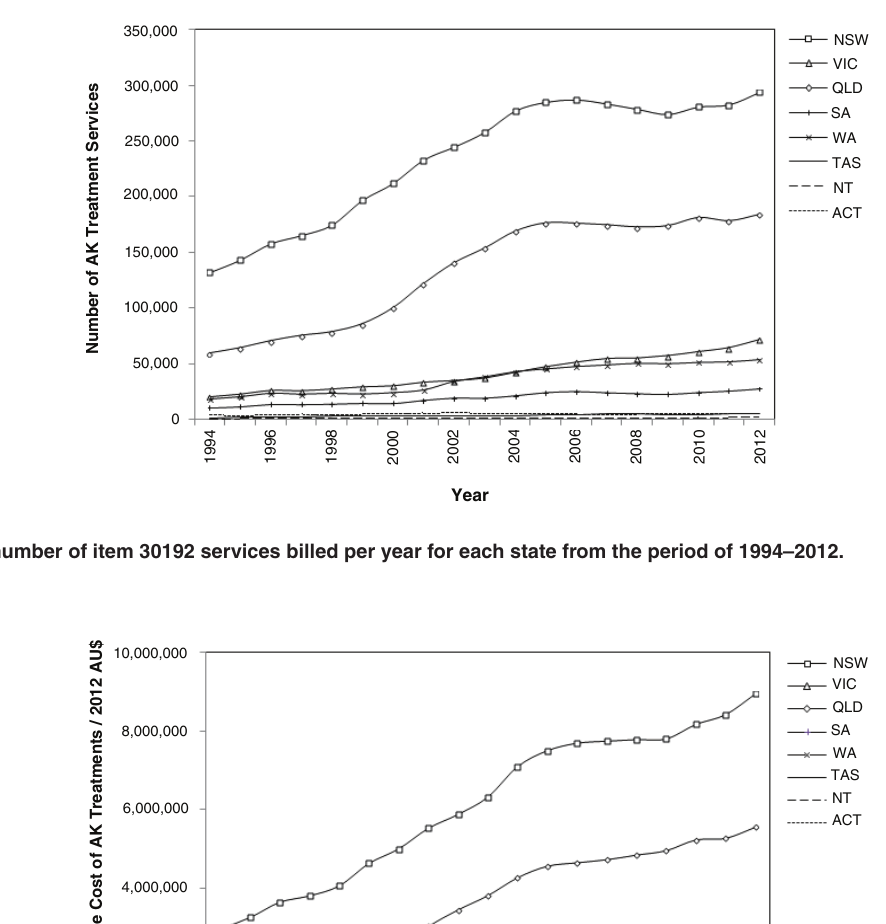
to increase by 17.8% compared with an increase in NMSC treat- ments of 22.3% which was predicted by Fransen et al. 14